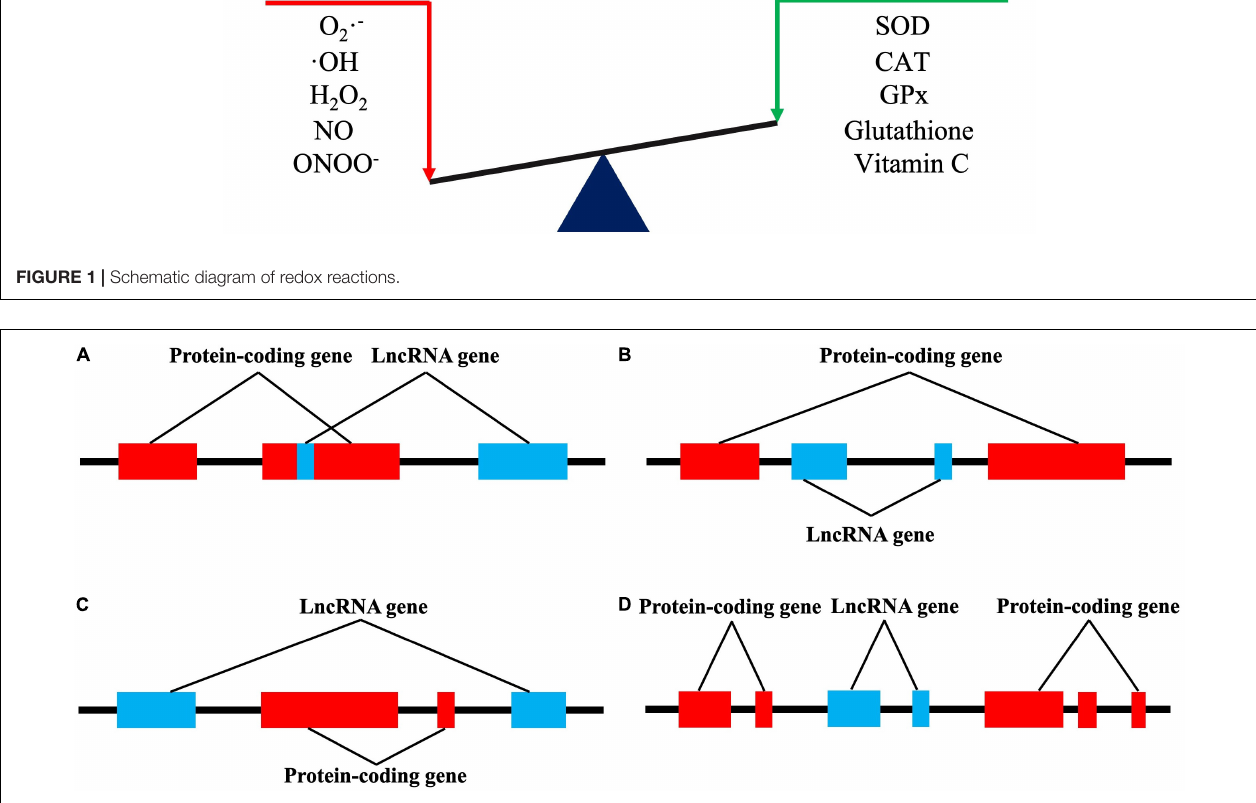
FIGURE 2 | lncRNAs are classified into four categories by their location relative to neighboring protein-coding genes. (A) Exon lncRNAs, (B) intron lncRNAs, (C) overlapping lncRNAs, and (D) intergenic